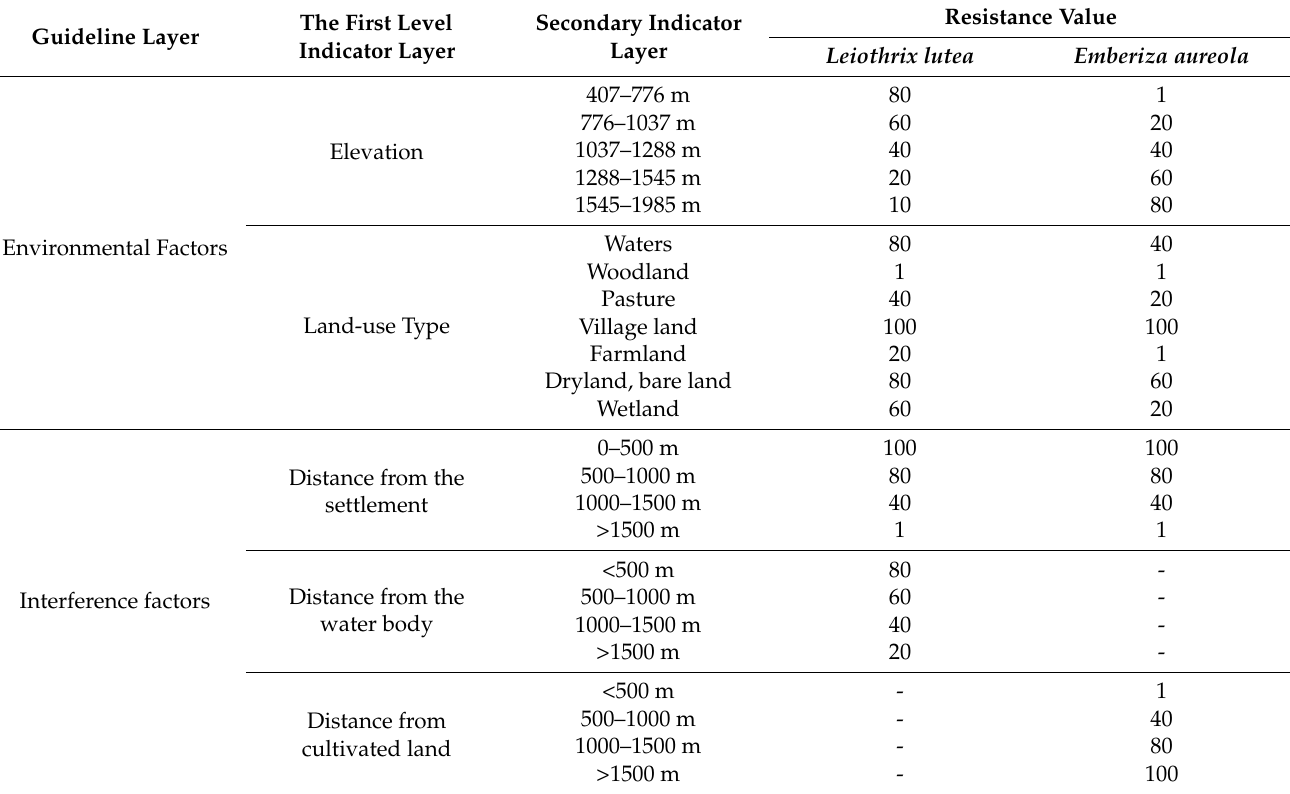
Table 2. The relative resistance-evaluation system.